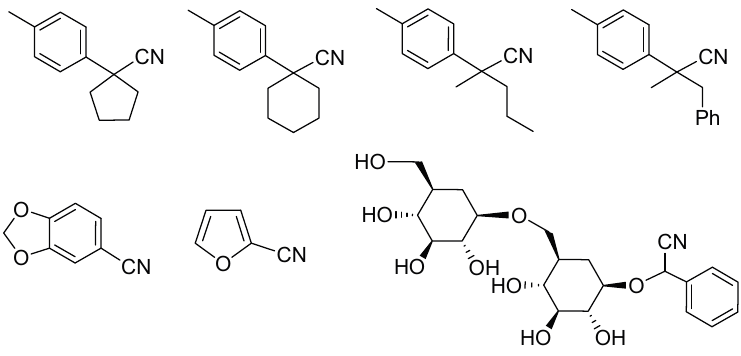
Figure 2. Examples of nitriles that complex 1 is able to